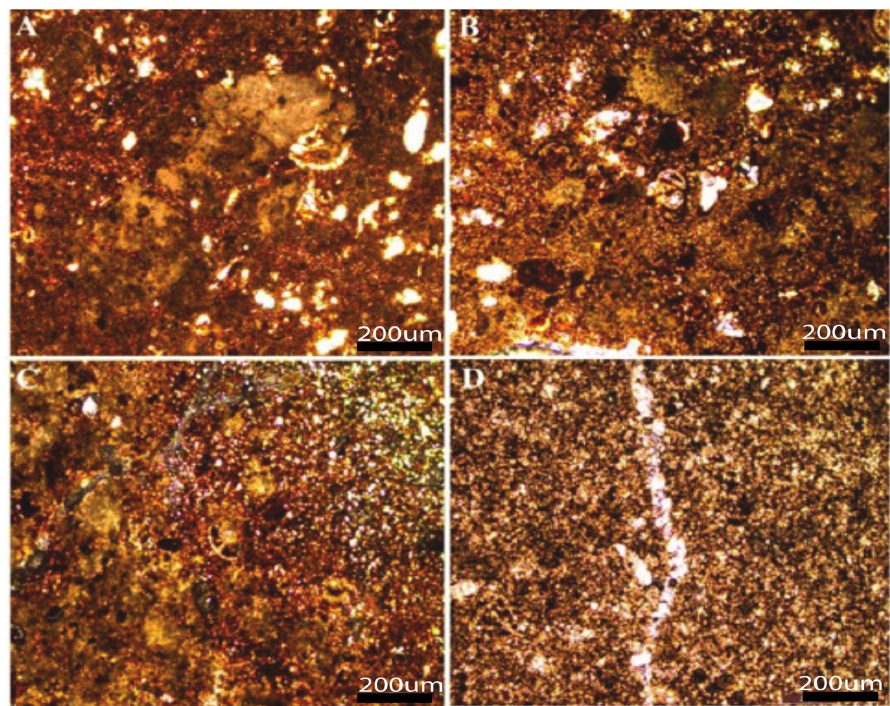
Figure 4. Photomicrographs showing: ( A , B ) precursor limestone with the micrite component giving a mudstone microfacies, close up the upper right part of ( A ) and the central part of photo ( B ) of planktonic foraminifera. ( C ) Mudstone microfacies are recognized in the lower part, while the upper right part illustrates the initiate of first replacement of micrite particles (early diagenesis). ( D ) The replacement process is commonly controlled in this micro-view, cross-cut by fracture-filling anhydrite minerals. This fracture still preserves the predated phase of fine dolomite.